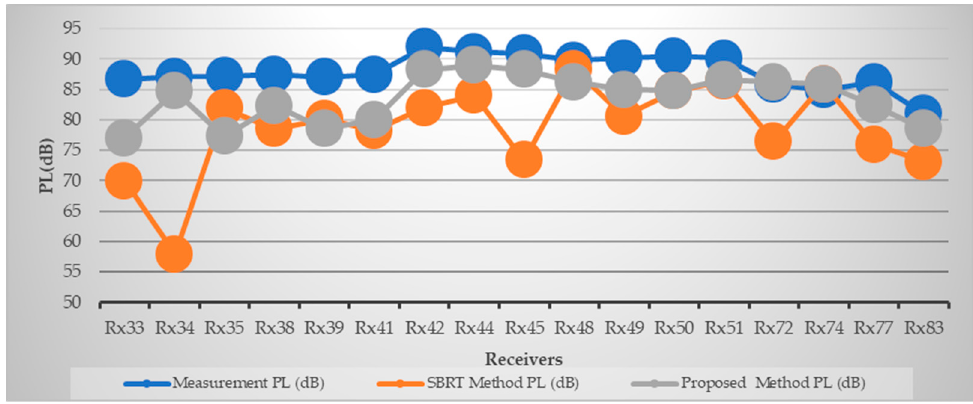
Figure 11. The PL comparison of line graphs among the measurement, SBRT method, and proposed method.